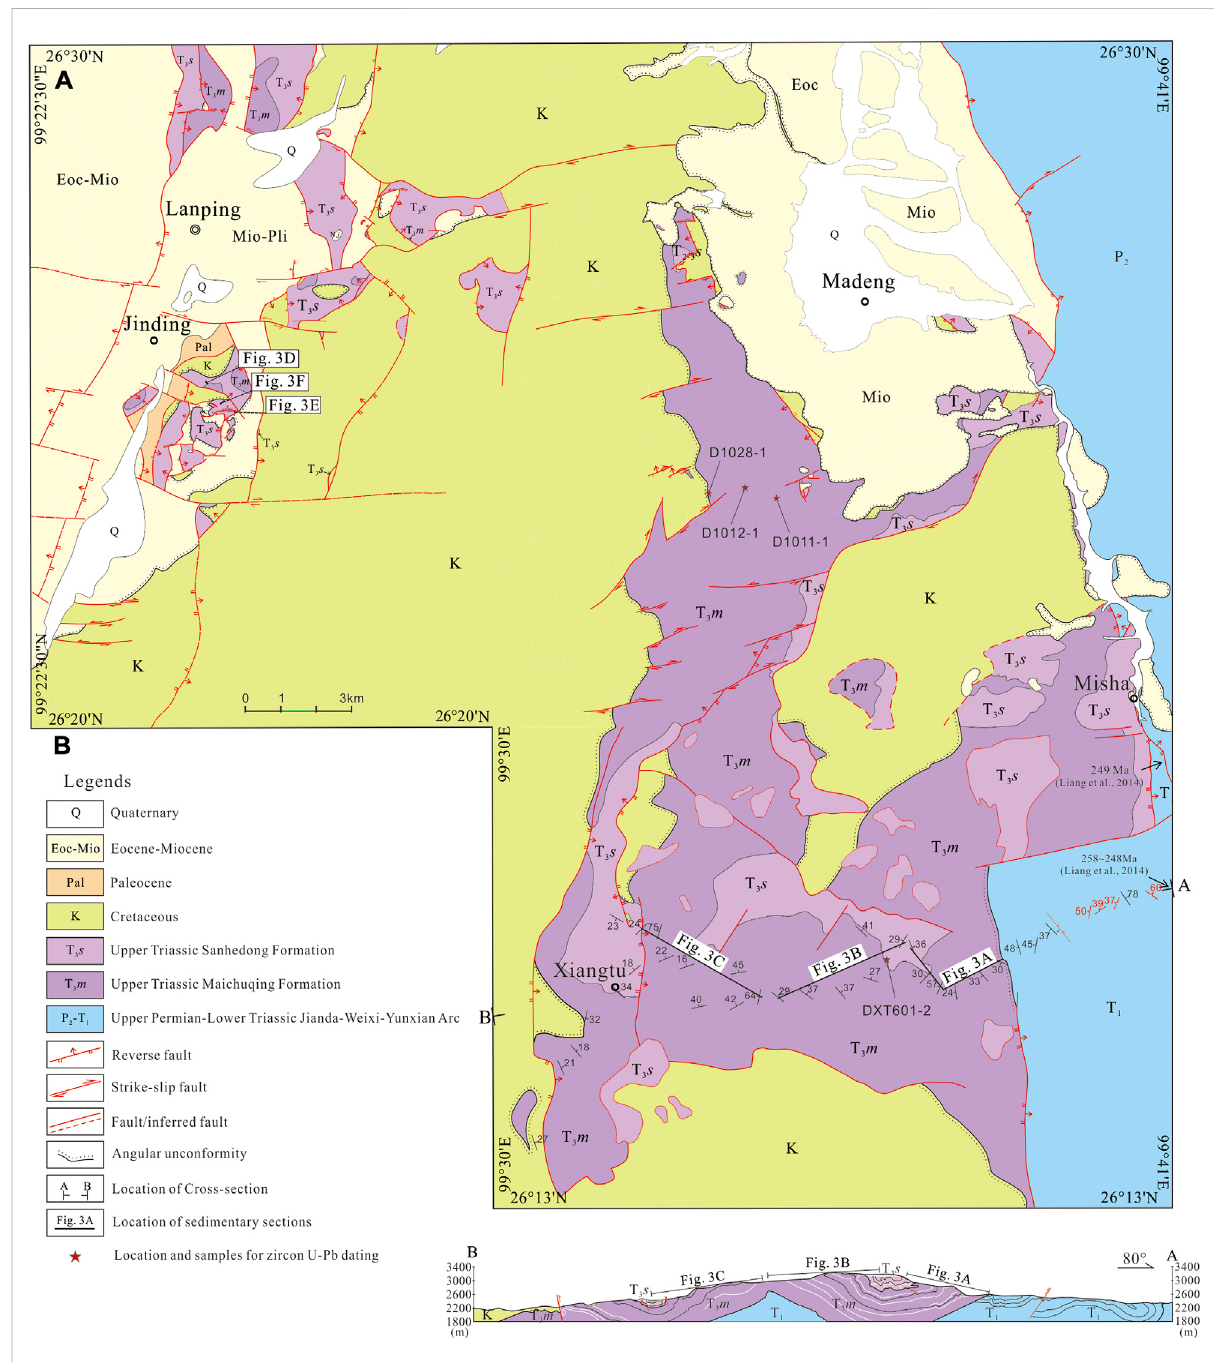
FIGURE 2 (A) Geologic map of Jinding – Madeng – Misha – Xiangtu area in the northwest Yunnan Province, China. Its location was marked in Figure 1B. (B) Cross-section showing the structures and contact relationships between the Upper Triassic and underlain strata along the Misha to Xiangtu pro fi